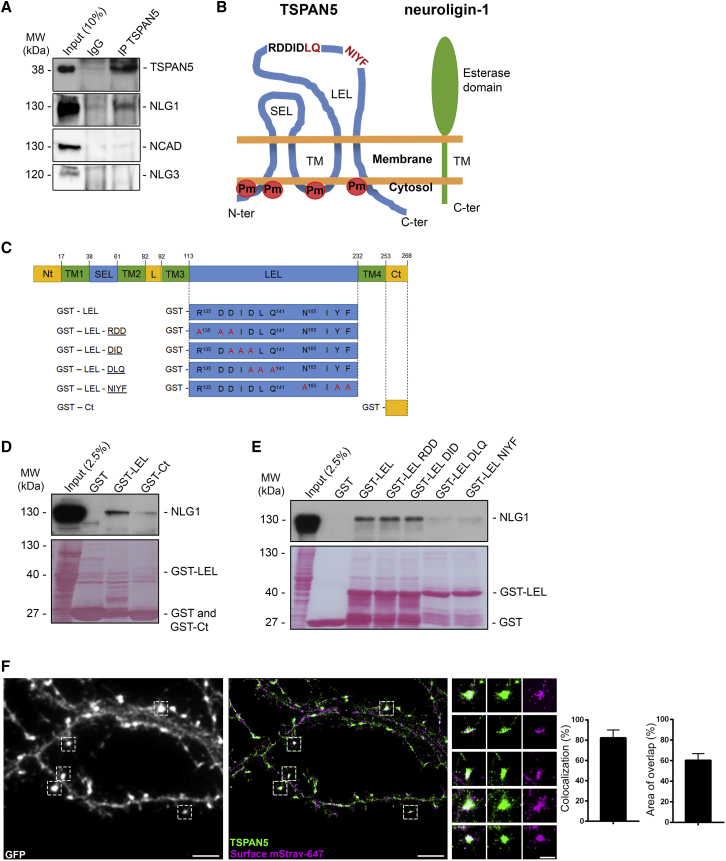
TSPAN5 Interacts with NLG1 through the LEL Domain(A) Co-immunoprecipitation experiments of adult rat hippocampus and cortex lysates in RIPA buffer. Input: 10% of immunoprecipitated volume. Immunoprecipitation: α-rabbit IgG or α-TSPAN5 antibody. Blots probed for TSPAN5, NLG1, N-cadherin (NCAD), and neuroligin-3 (NLG3).(B) Schematic of TSPAN5 (blue) and NLG1 (green) structure. TSPAN5 structure inferred by homology with other tetraspanins. C-ter, C terminus; LEL, large extracellular loop; N-ter, N terminus; SEL, small extracellular loop; TM, transmembrane regions. The R135DDIDLQ141 and N165IYF168 sequences of LEL are shown; residues involved in NLG1 interaction are indicated in red. Palmitoylation (Pm) sites mutated in the PLM (Figure 6D) are highlighted in red. Plasma membrane shown in orange.(C) Schematic of GST constructs used in pull down experiments. TSPAN5 domains are highlighted: in yellow, intracellular domains (Ct, C-terminal; L, loop; Nt, N-terminal); in green, transmembrane domains (TM1–TM4); and in blue, extracellular domains (LEL, large extracellular loop; SEL, small extracellular loop). Constructs with mutated residues highlighted in red.(D) GST pull down experiments in adult rat hippocampus and cortex lysates using empty GST, GST fused to LEL (GST-LEL), or GST fused to the C terminus (GST-Ct). The input was 2.5% of the pull down volume. Blots probed for NLG1. Red Ponceau shows GST-bound fragments.(E) GST pull down experiment in adult rat hippocampus and cortex lysates using empty GST, GST-LEL, or GST fused to LEL with different mutations: RDD, DID, DLQ, and NIYF. The input was 2.5% of the pull down volume. Blots probed for NLG1. Red Ponceau shows the GST-bound fragments.(F) dSTORM images of DIV 12 hippocampal neurons transfected with sh-Nlg1 (expressing GFP), AP-NLG1, and BirA-ER surface labeled with mStrav-647 (purple) and labeled after fixation and permeabilization with α-TSPAN5 antibody (green). Scale bar, 4 μm. Right images show higher magnification of regions highlighted in white; scale bar, 1 μm. Histograms show percentage of TSPAN5 puncta colocalizing with AP-NLG1 and percentage of area overlap. n = 4 neurons.Exact values are shown in Table S1. See also Figure S3. Graphs represent mean ± SEM.